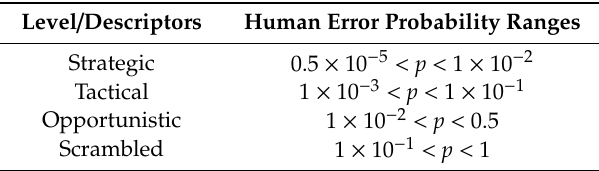
Figure 2. Output membership functions—control modes. Of probability interval Table 2. Control Modes and Human Failure Probability.